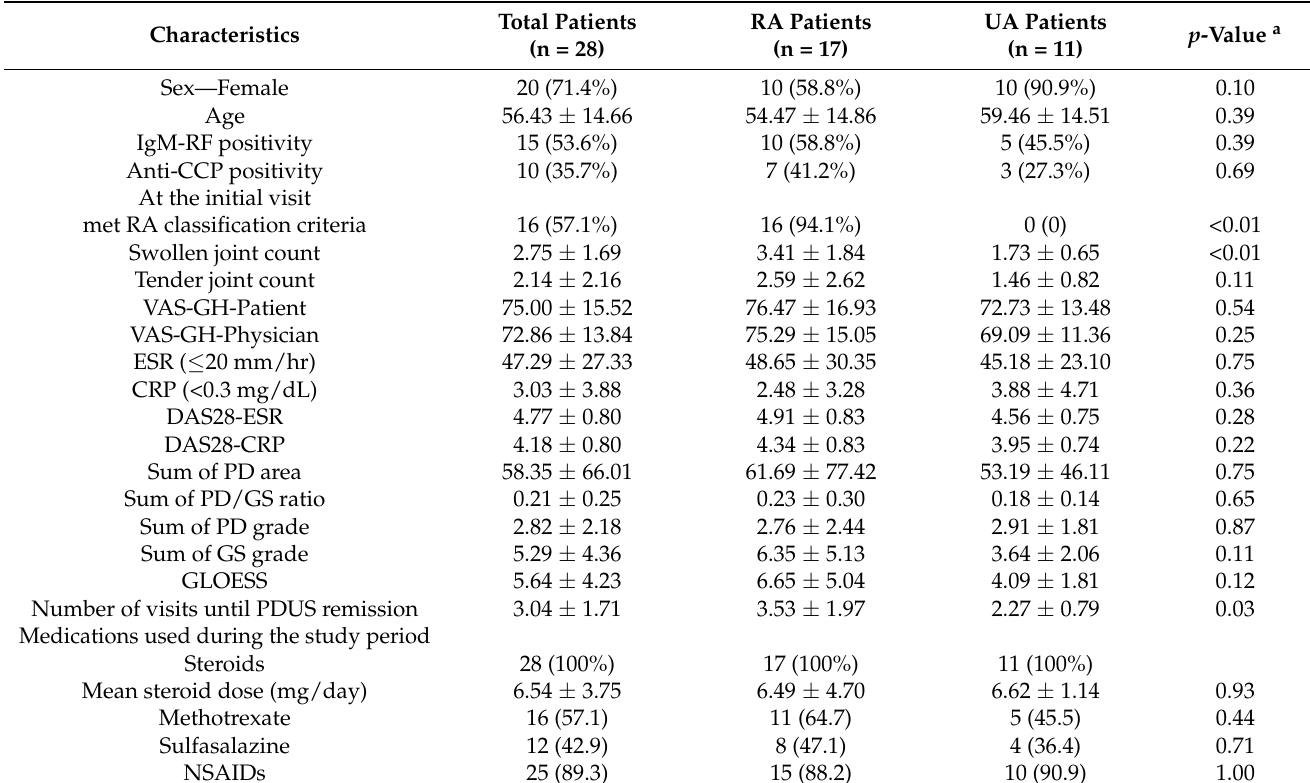
Table 1. Demographic and clinical characteristics.